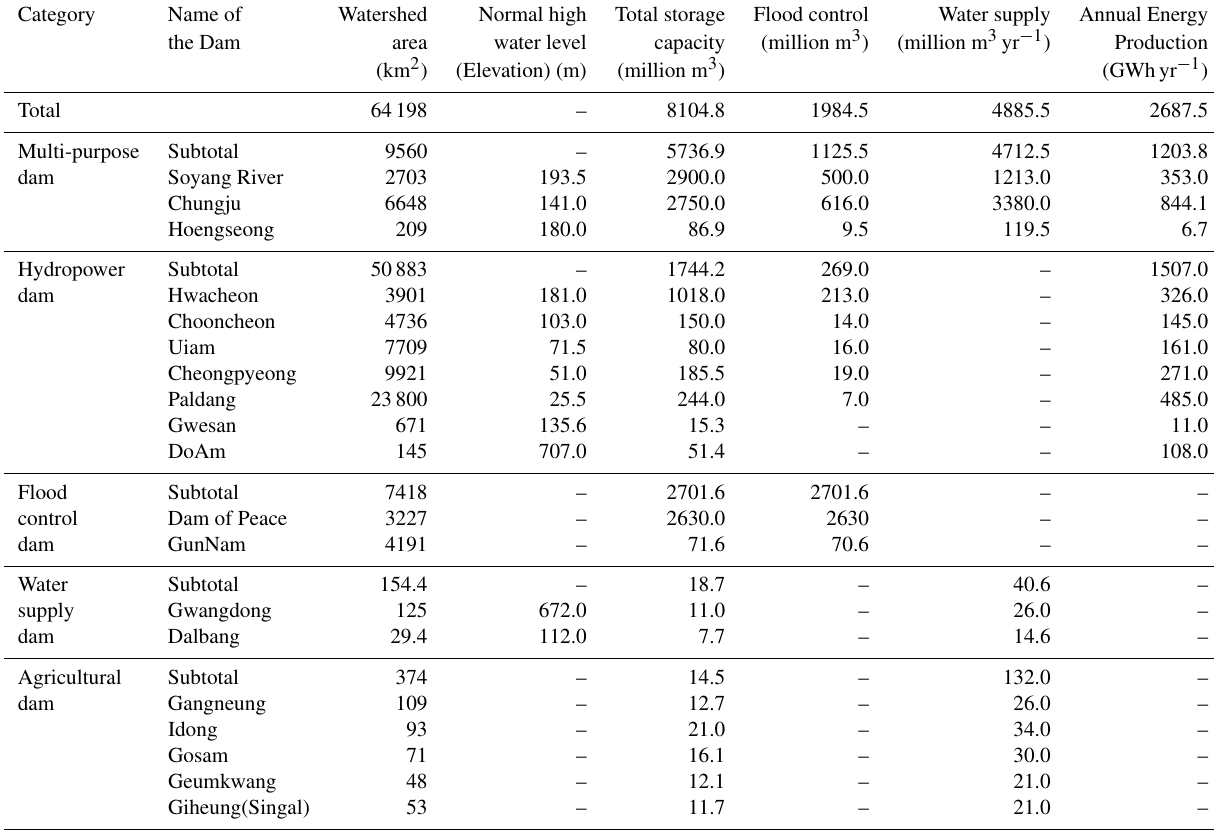
Table 2. The current status of dams in the Han River Watershed.